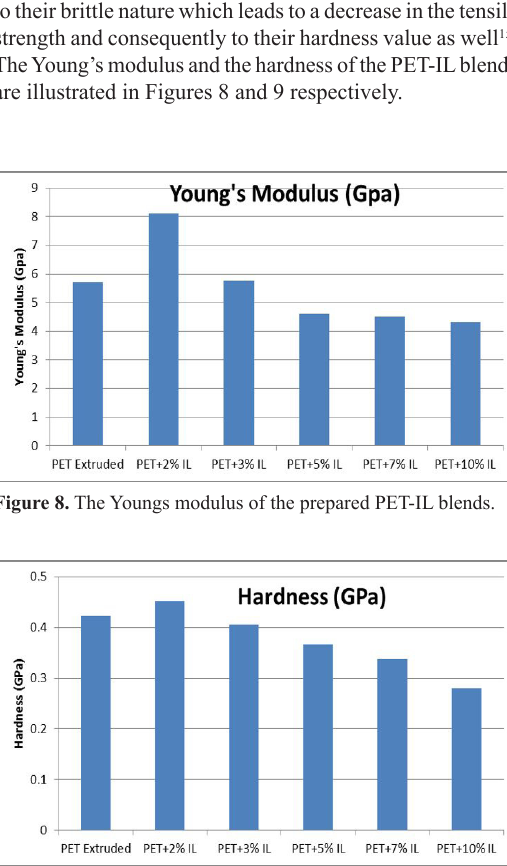
Figure 9. The hardness of the prepared PET-IL blends.